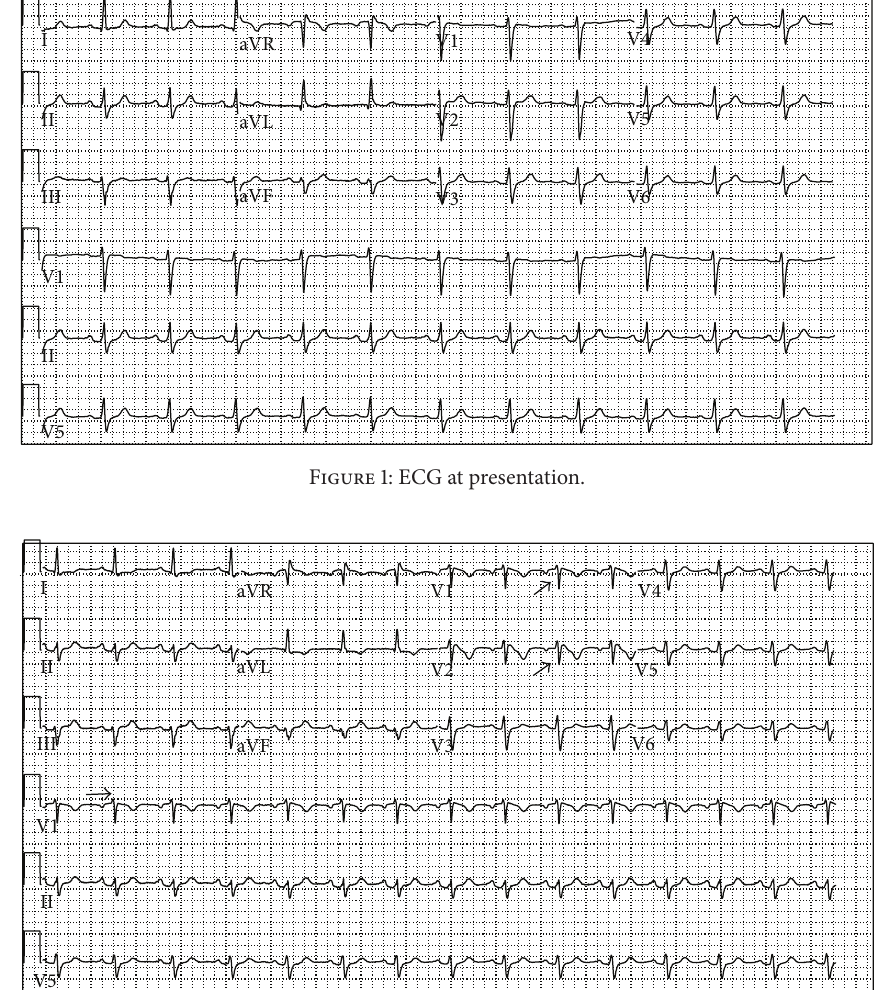
Question: Does the Patient Have an Underlying Primary Electrical Disturbance? This ECG shows normal sinus rhythm with a widened QRS complex (140 ms) at 66 beats per minute with a left axis deviation. On careful inspection, ST-segments in V1 and V2 show a < 1 mm elevation and flattening of T waves in V1, in this otherwise normal